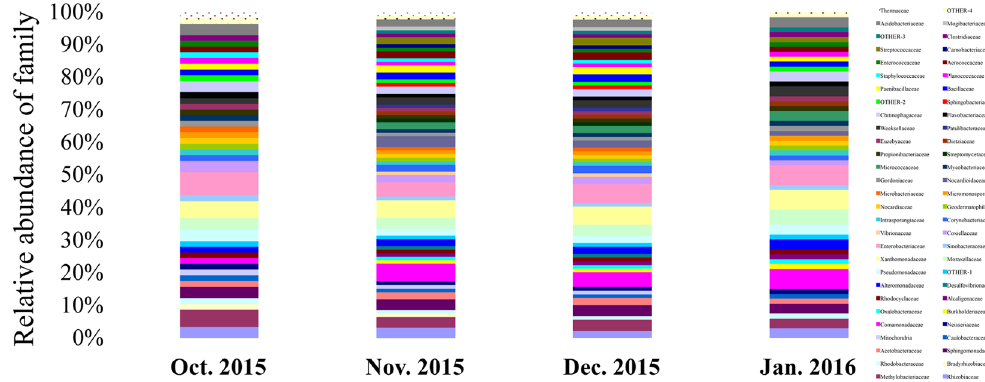
Figure 8. Bacterial community structure variation during overwintering stage at the family level of Dendroctonus armandi